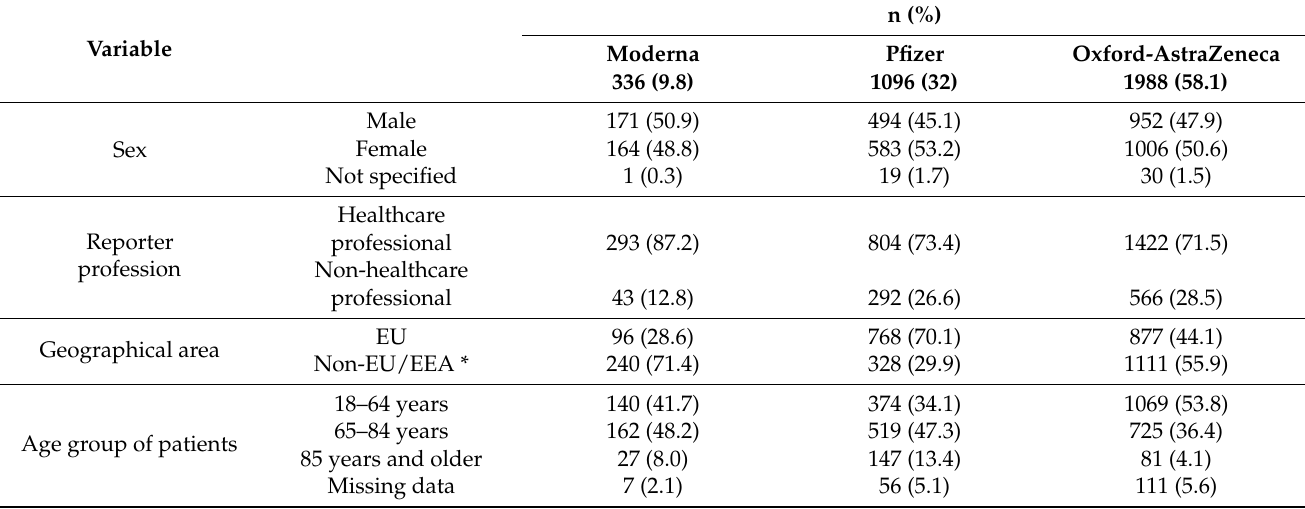
Table 1. Summary of demographics of EudraVigilance database thrombotic adverse event reports (N = 3420) for Moderna, Pfizer and Oxford-AstraZeneca